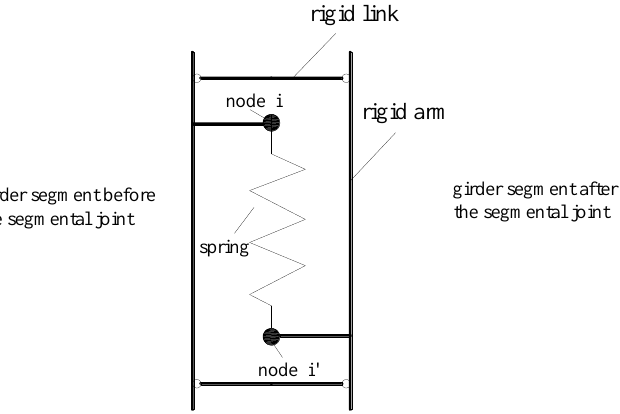
Figure 8. Constraint relationship between coincident nodes at the segmental joint.